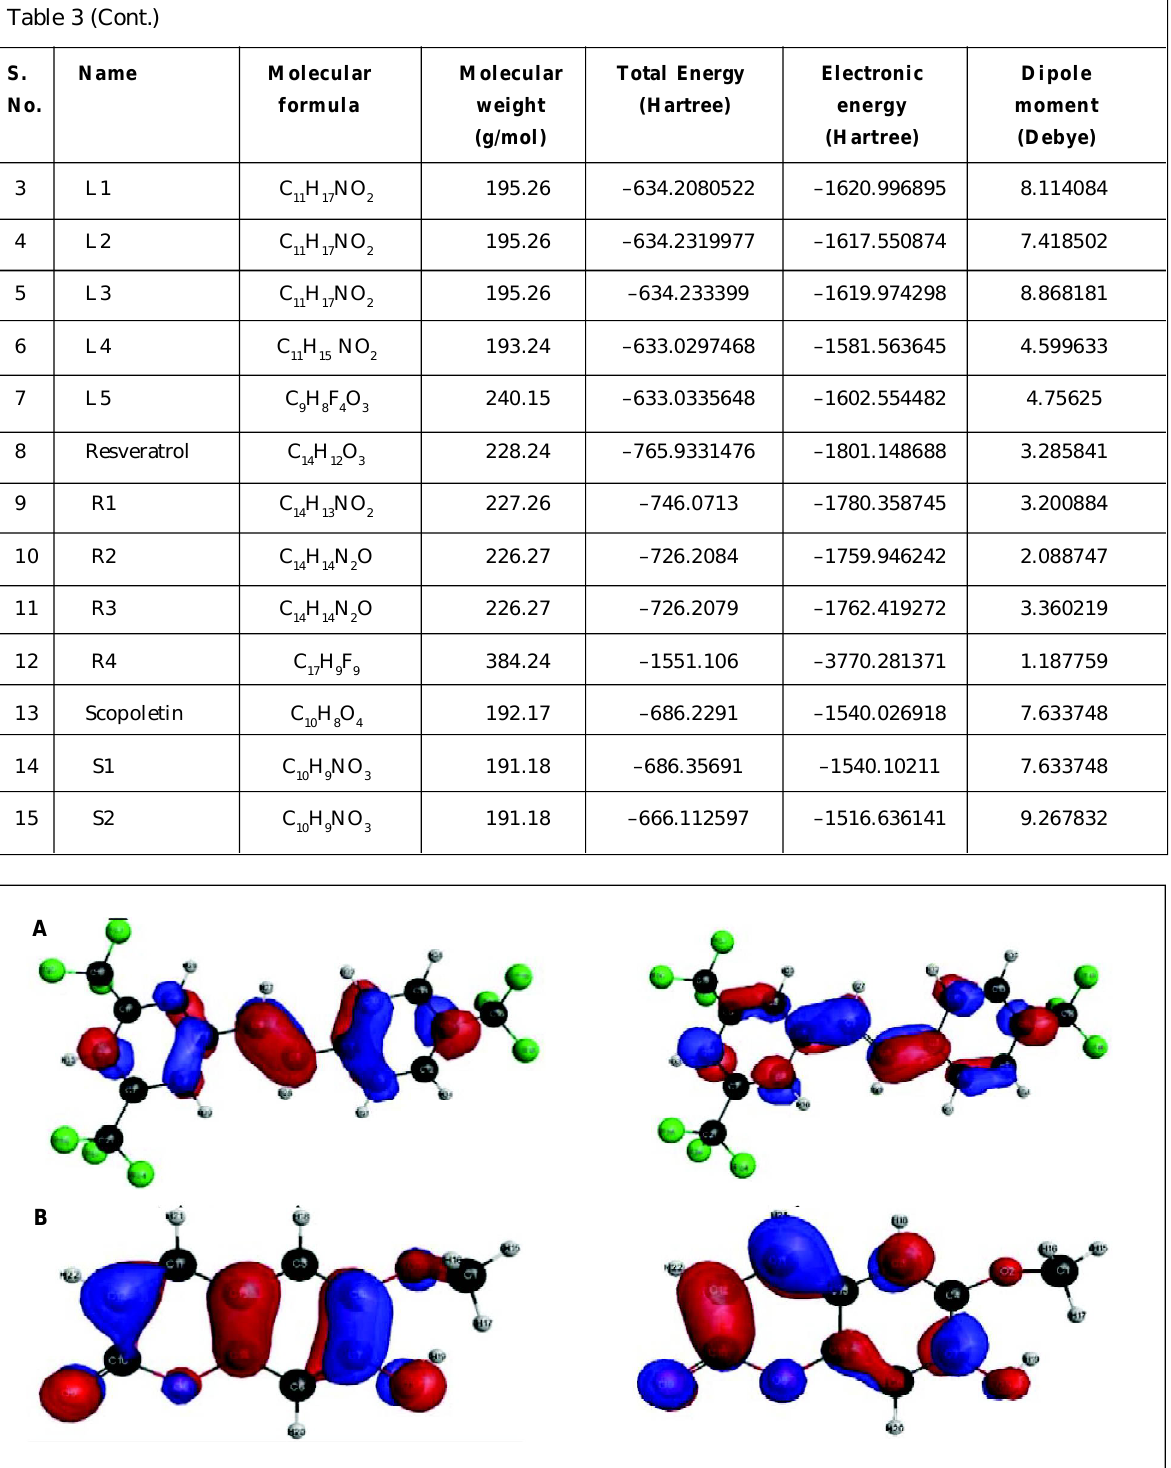
Figure 3: The color-coded frontier molecular orbitals depicting the Highest Occupied Molecular Orbital (HOMO) and the Lowest Unoccupied Molecular Orbital (LUMO): (A) Resveratrol derivative-R4; (B) Scopoletin